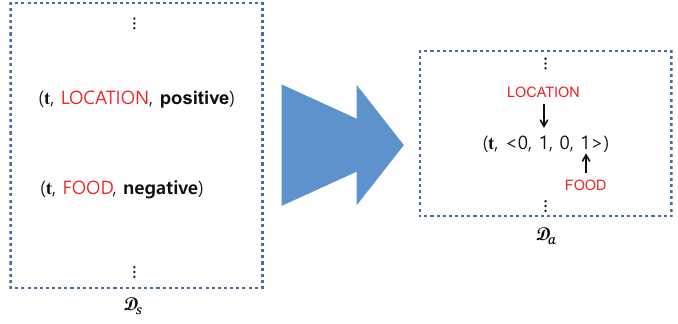
Figure 5. D a expresses D s more compactly by incorporating all aspects for the same text t .